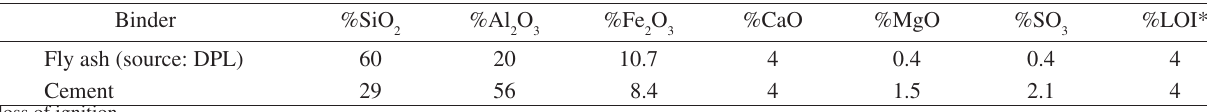
Table 4. Chemical composition (%) and properties of binding materials.